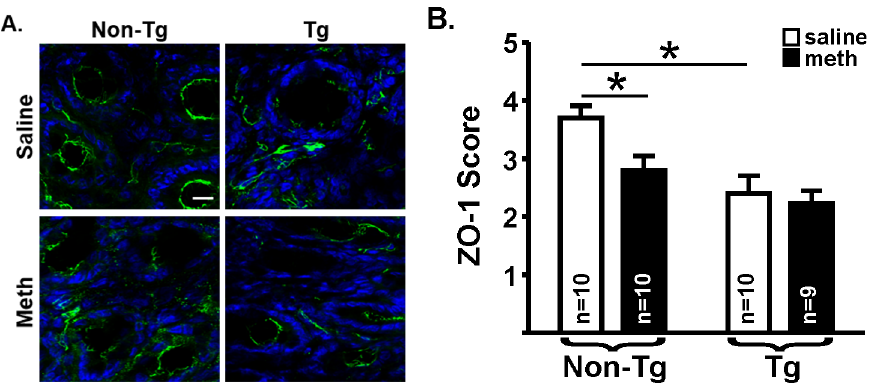
Fig 5. ZO-1 immunofluorescence. (A) Representative photomicrographs of ZO-1 immunofluorescence (red) in the distal colon of saline-yoked (top) and methamphetamine self-administering (bottom) non-Tg (left) and Tg (right) rats. Sections were counterstained with DAPI (blue) to identify crypts. Saline-yoked non-Tg exhibited continuous ZO- 1 immunofluorescence around the epithelial cells within the crypts (top, left) ; whereas non-Tg rats that self- administered methamphetamine had discontinuous ZO-1 immunofluorescence (bottom, left). Saline-yoked non-Tg and Tg rats that self-administered methamphetamine also had discontinuous ZO-1 immunofluorescence (right) . White bar = 25 μ m. There was no group difference in intensity of ZO-1 immunofluorescence. (B) A scale from 0–4 was used to score ZO-1 immunofluorescence (see Methods). As indicated by horizontal lines above the bars, scores differed significantly between saline-yoked (open bars) non-Tg and saline-yoked Tg rats, and saline-yoked non-Tg and methamphetamine self-administering (filled bars) non-Tg rats. Mann-Whitney U -tests corrected for multiple comparisons ( (cid:3) p <